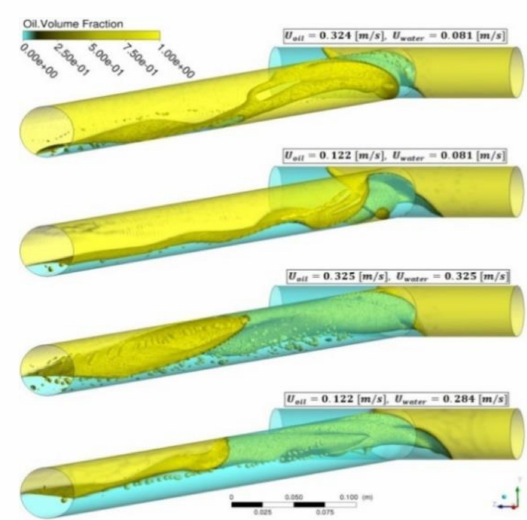
Figure 7. Iso-area of the volume fraction of oil in the whole domain at di ff erent inlet velocities of oil and water.